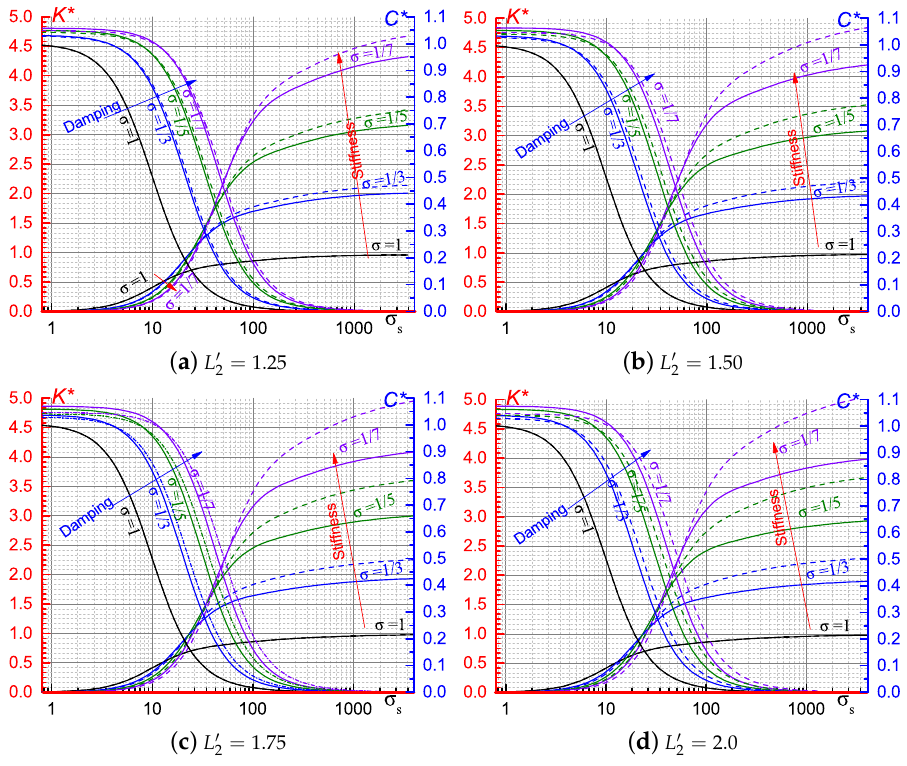
Figure 16. Dynamic coefficients of the 1D ring with supply pressure under different radius